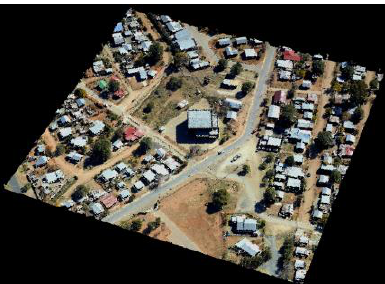
Figure 13. The point cloud rendering results conbining with spectral information in African area